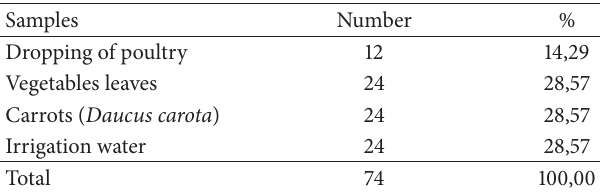
Table 2: Situation of the samples collected on the market site. Samples Dropping of